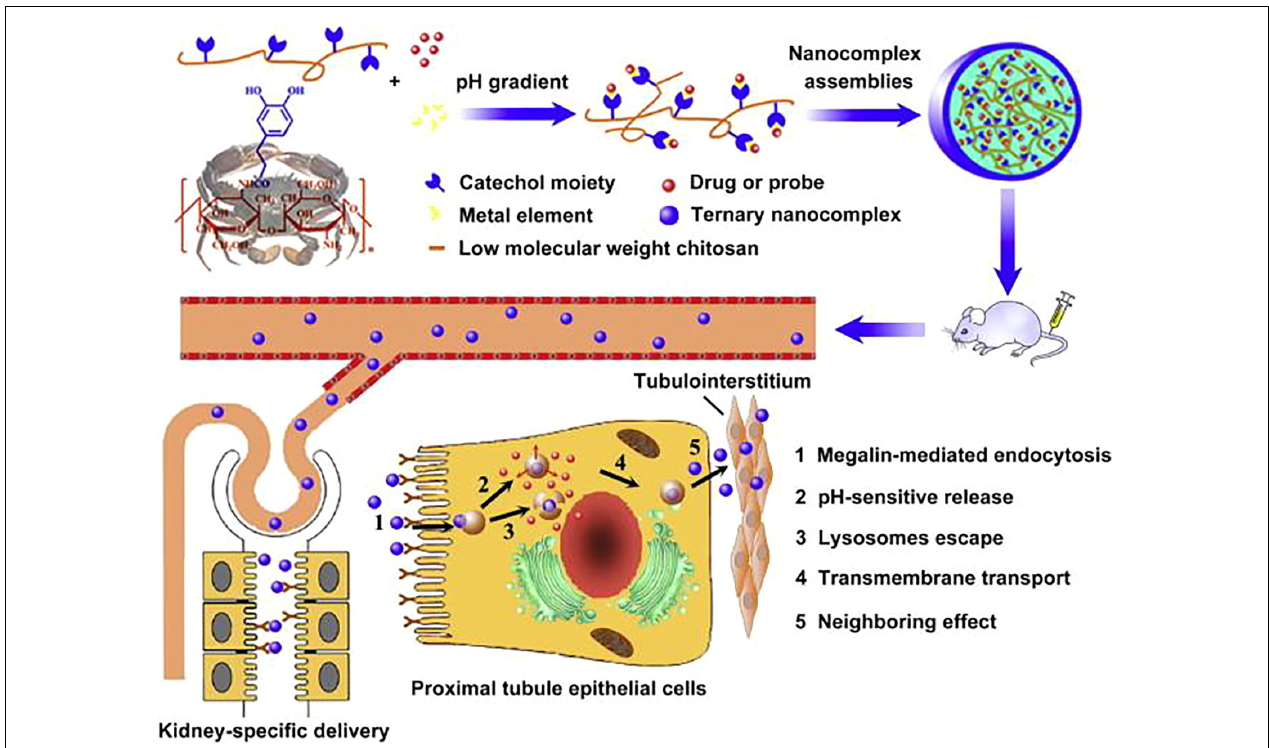
FIGURE 4 | HCA-Chi for kidepH-response nanodevice based on a coordination-driven assembly of HCA-Chi for sequential and kidney-specific drug delivery. Reprinted with permission (Qiao et al.,